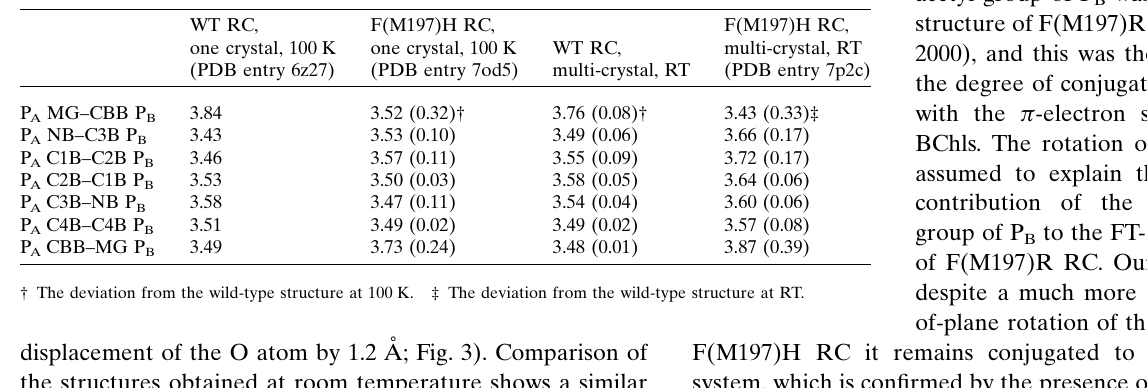
Table 3 Distances between BChl P A and P B in the area of pyrrole ring I (A˚ ).